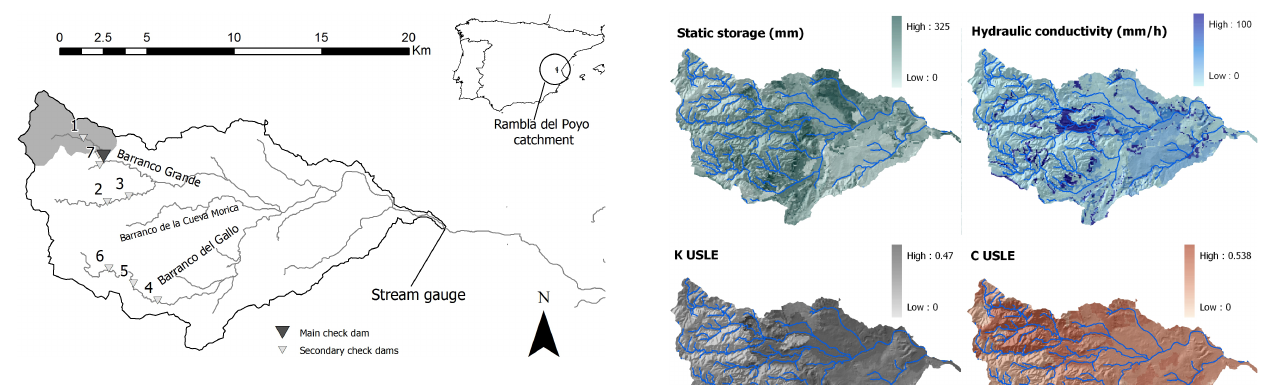
Fig. 2. Location of the catchment and check dams. The grey area is the check dam subcatchment used for sediment sub-model calibra- tion and temporal validation.